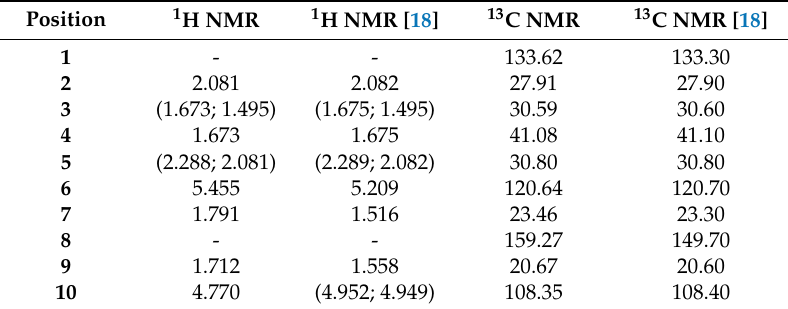
Table 3. NMR data of the substance Limonene (S 4) compared to literature